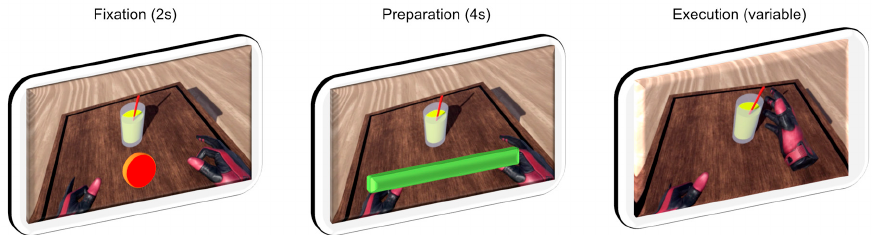
Figure 2. Visualization of one complete trial, along with timings. Rest phase between trials not shown.